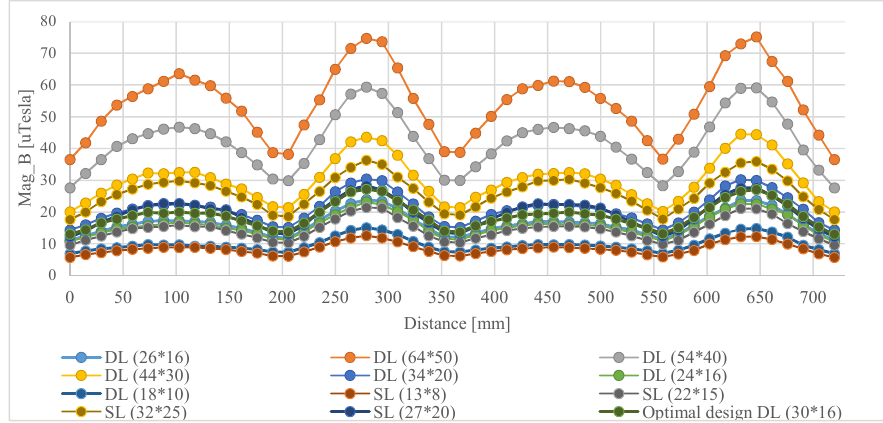
Figure 8. Magnetic-field density ( B ): comparison of different WPT systems.